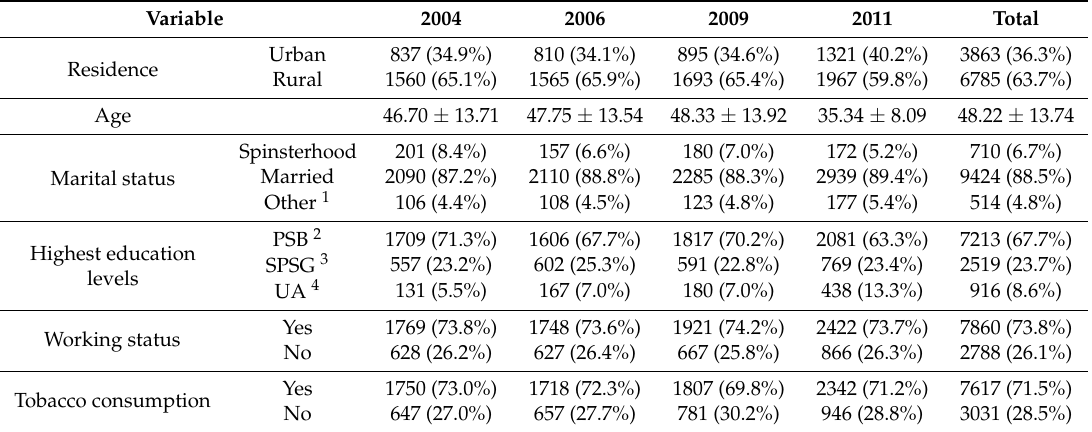
Table 1. Characteristics of 10,648 participants stratified by the survey year ( n , %),